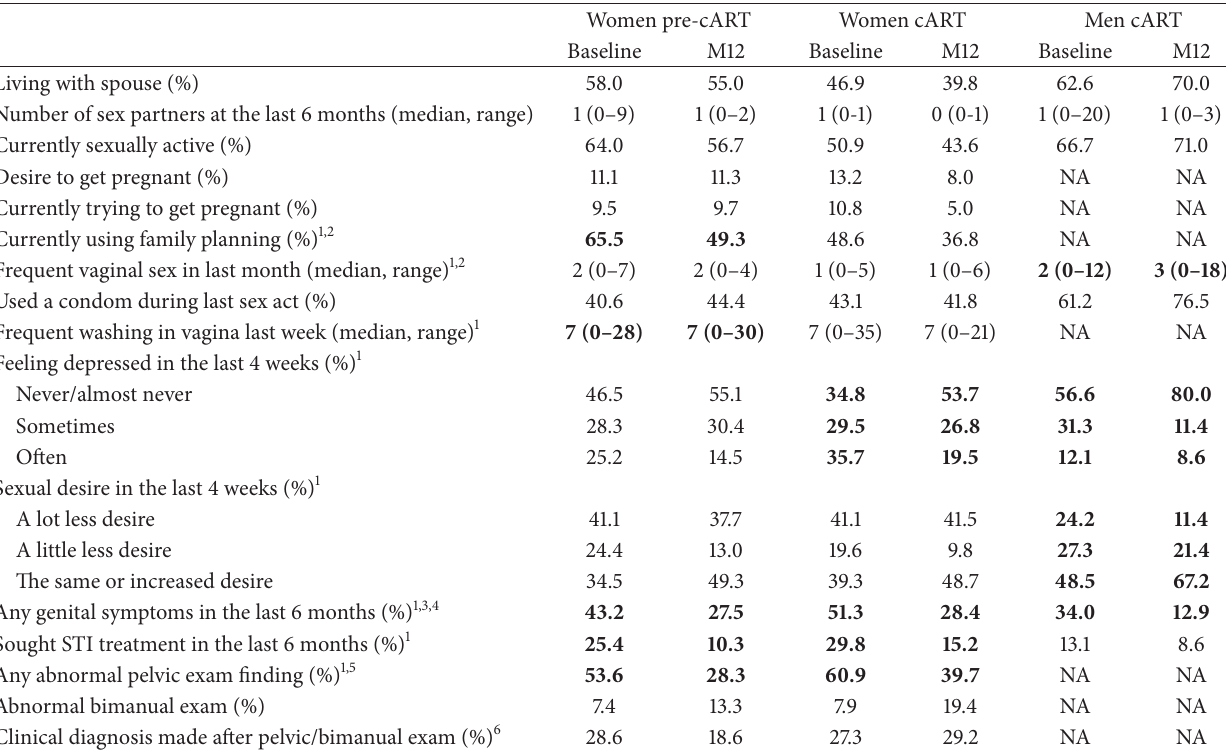
Table 4: Behavioral and clinical changes over time by study